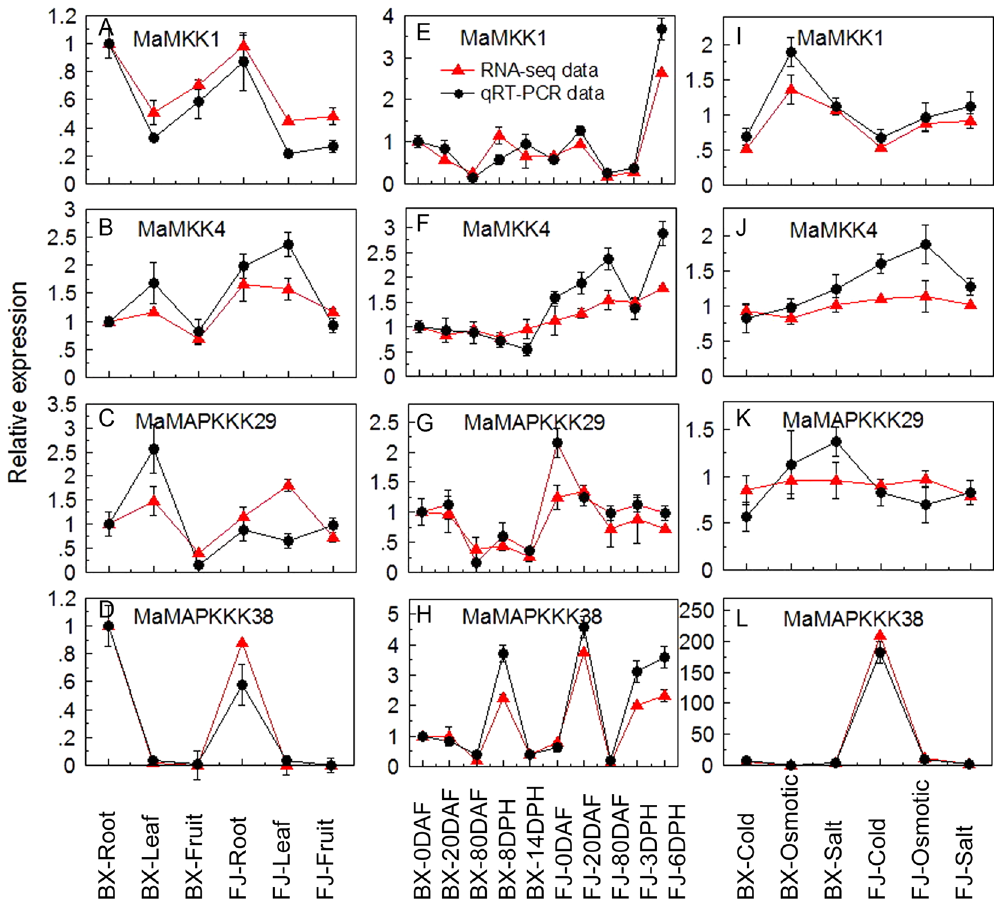
Figure 11. qRT-PCR analysis of relative expression of MaMKK and MaMAPKKK genes in BX and FJ. ( A – D ) Expression patterns of MaMKK1 , MaMKK4 , MaMAPKKK29 and MaMAPKKK38 in different organs. The mRNA fold difference was relative to that of BX-root samples used as calibrator. ( E – H ) Expression patterns of MaMKK1 , MaMKK4 , MaMAPKKK29 and MaMAPKKK38 in different stages of fruit development and ripening. The mRNA fold difference was relative to that of BX-0DAF samples used as calibrator. ( I – L ) Expression patterns of MaMKK1 , MaMKK4 , MaMAPKKK29 and MaMAPKKK38 in response to cold, osmotic and salt stresses. The mRNA fold difference was relative to that of untreated samples used as calibrator. Log2 based values were used to display differential expression results. Data are means ± SD of 3 biological